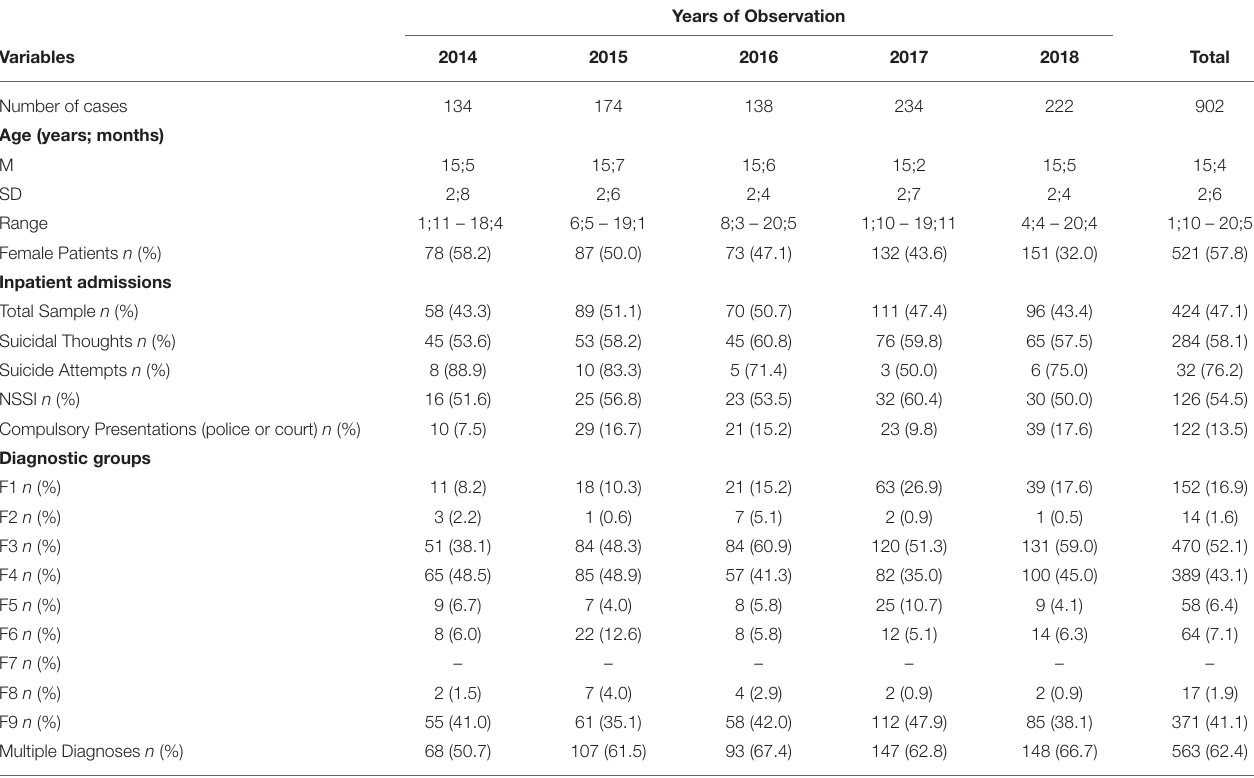
TABLE 1 | Demographic and clinical characteristics of the sample per 4th quarter over the years of observation.